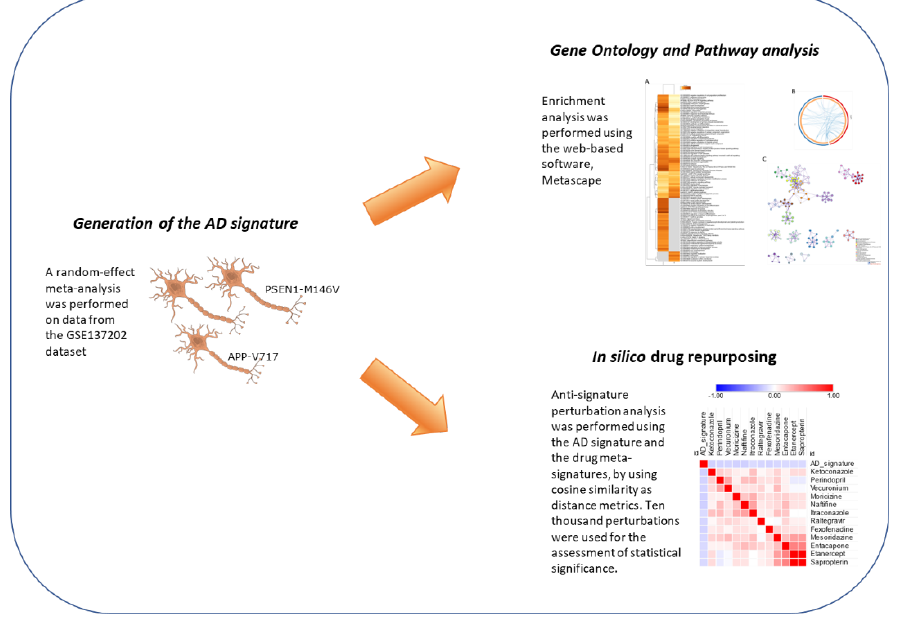
Figure 1. Experimental